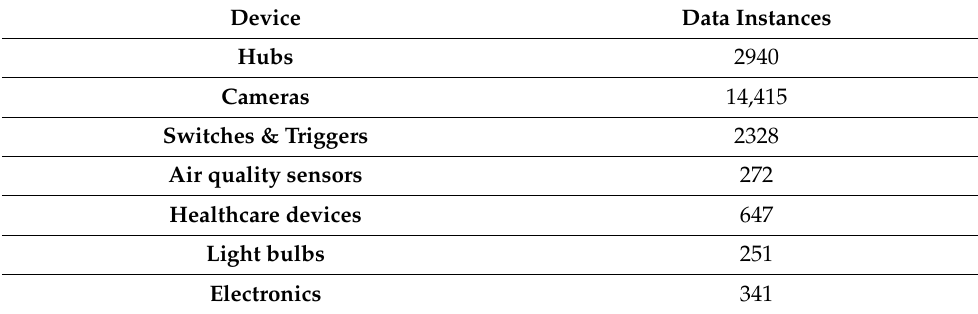
Table 6. Statistics on the number of data instances for each category.